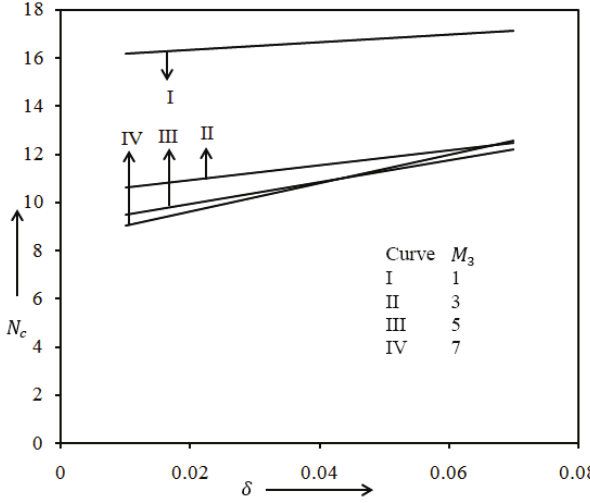
Fig. 5. Variation of critical magnetic Rayleigh number ( N c ), with magnetic field-dependent viscosity (  ) for M 3 = 1, 3, 5, and 7 for curves I, II, III and IV,